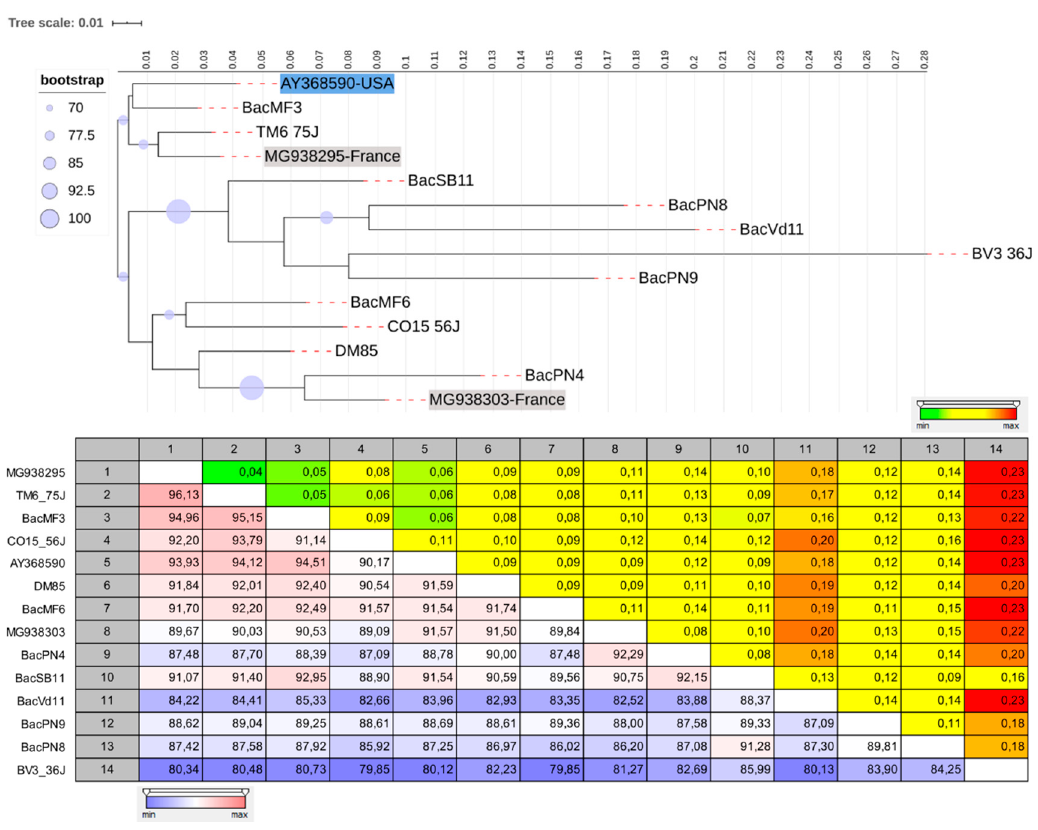
Figure 8. Maximum likelihood phylogenetic tree constructed from recovered consensus partial sequences of grapevine Ruspestris stem pitting-associated virus ( GRSPaV ) . Neighbor-joining construction method with 1000 bootstrap replicates was used. Branch length represents phylogenetic distances determined with distances matrices of nucleotide sequences. Purple dots above critical branches are significant bootstrap values (>70%). GenBank accession numbers of fully sequenced genomes from different countries are highlighted for reference. Isolates from this study are represented and are not highlighted. The percent of identity (purple-red scale) and Jukes–Cantor distance (yellow-red scale) are represented for each pair of sequences of GRSPaV. The percent of identity is the proportion of identical residues in the alignment positions to overlapping alignment positions between the two sequences. The distance was calculated using the Jukes–Cantor distance between the two sequences and is the proportion between identical and overlapping alignment position between two sequences. R package phylogram and the interactive tree of life platform was used to generate the tree (see the materials and methods section for more details). 4. Discussion Growers’ increasing experience and expertise in northern viticulture and climate change represent an opportunity for major change in Quebec’s grapevine industry by allowing a shift from traditionally cultivated hybrid cultivars (e.g., interspecific hybrids Vidal) into cultivars with lower cold hardiness and disease tolerance, such as Vitis vinifera (Pinot noir). However, this situation comes with potential risk including grapevine leafroll disease (GLD), one of the most economically damaging grapevine diseases. Considering that the disease is latent in some grapevine hybrid cultivars (e.g., Vidal) and that these cultivars will continue to be grown, they can serve as a virus reservoir [14]. In this study, we characterized the virome of the interspecific hybrid cultivars and compared it to the virome of a V. vinifera cultivar to guide grapevine producers during the transition. Grapevine leafroll-infected plants had a diverse virome in terms of composition, abundance and richness. Three viruses (GRSPaV, GLRaV-3 and GLRaV-2) and one viroid (HSVd) largely dominated the overall virome. However, their presence and abundance can be sorted by grapevine cultivars. Indeed, in the hybrid cultivar Vidal, GRSPaV dominated the virome with 61% of the viral population,